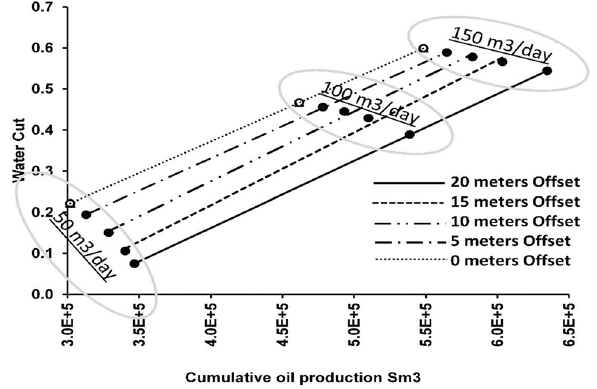
Fig. 6 Sensitivity results of vertical